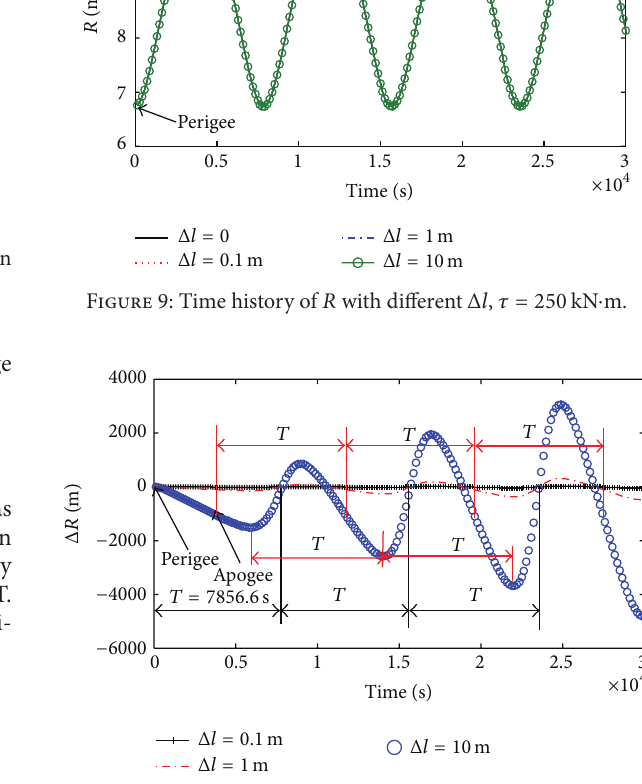
Figure 10: Time history of Δ𝑅 with different Δ𝑙 , 𝜏 = 250 kN ⋅